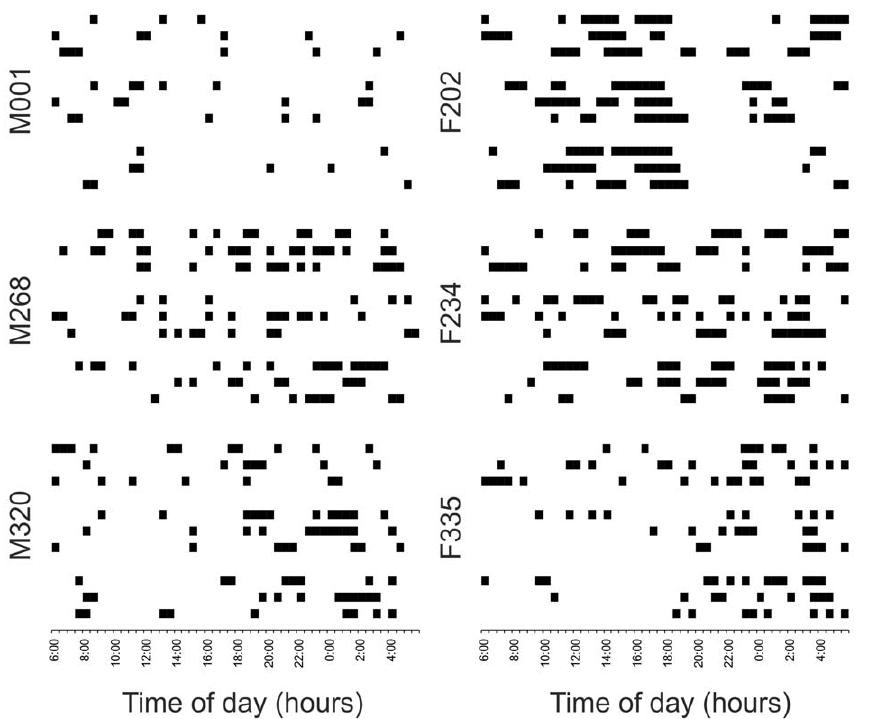
Figure 3. Actograms of the six giant mole-rats radio-tracked during the three continuous 72-h radio-tracking sessions. Dark bars represent bouts of activity (occurrence outside the nest).